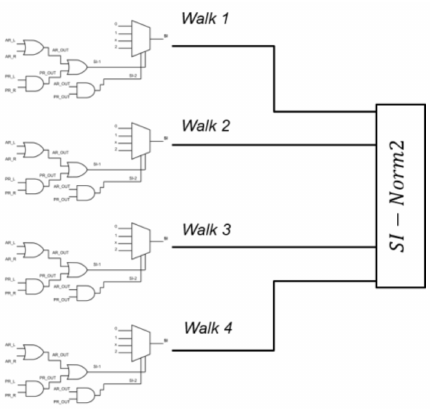
Figure 4. Four SI values enter a squared norm algorithm to determine an overall “SI-Norm2” severity